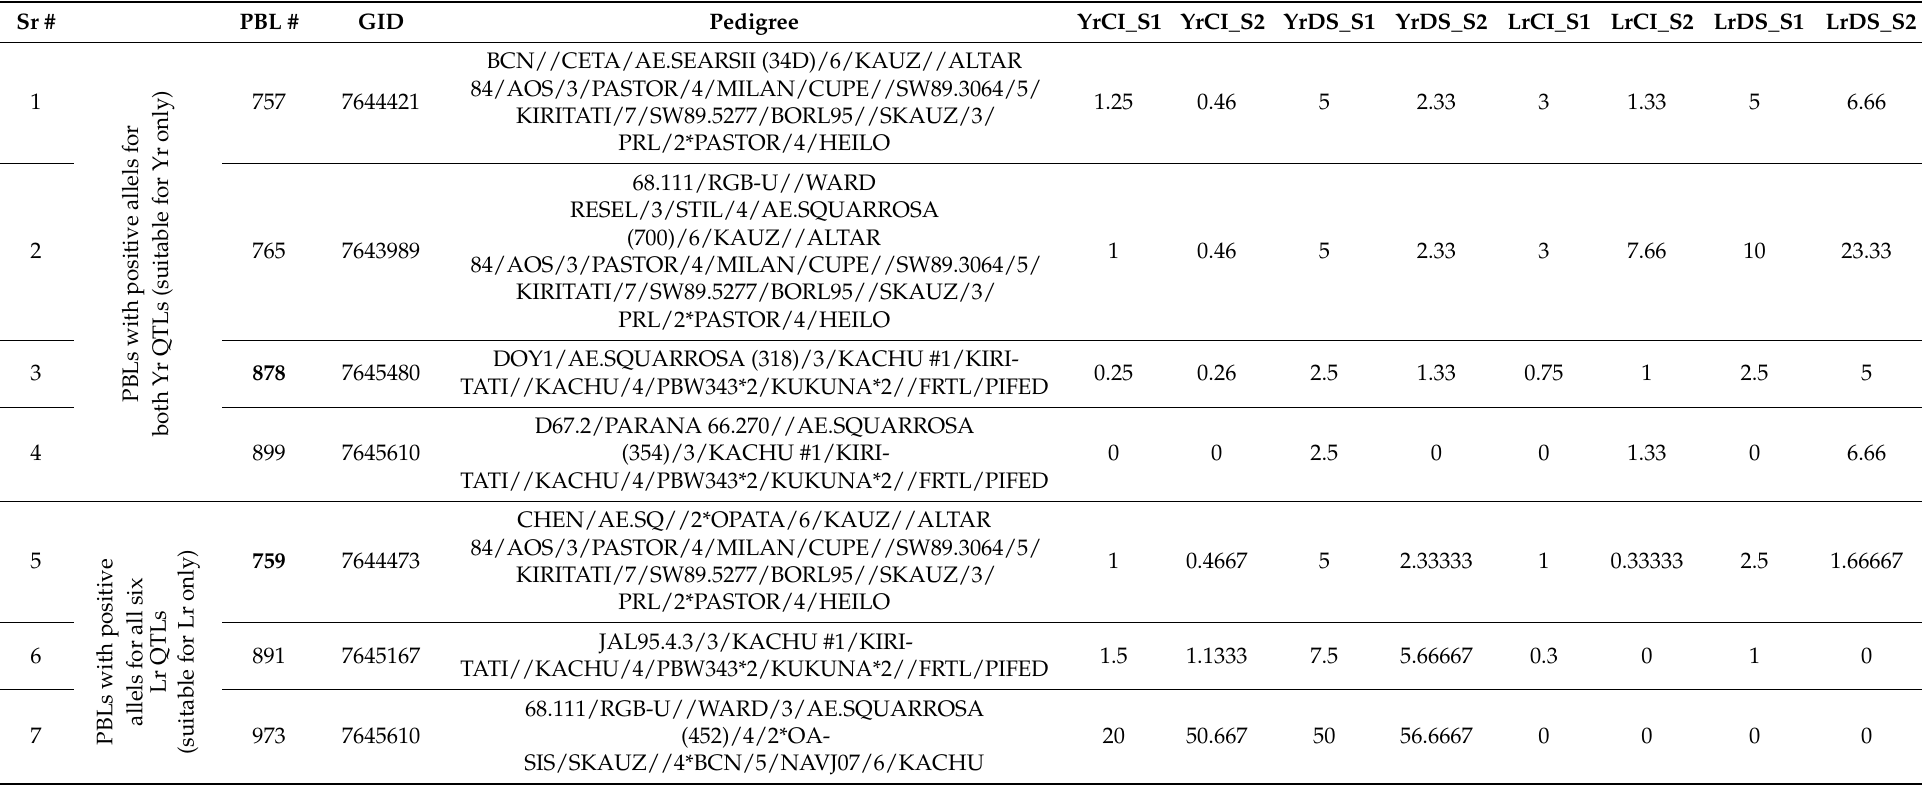
Table 1. List of PBLs suitable for Yr or Lr or